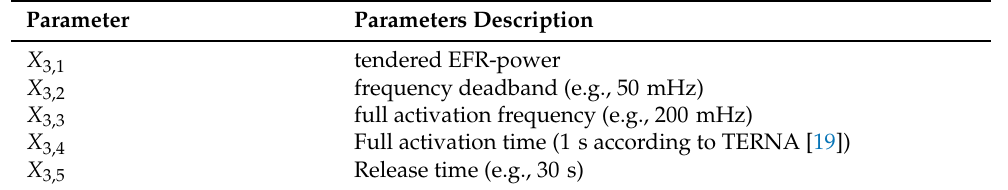
Table A2. Parameters X 3 of function F 3 .